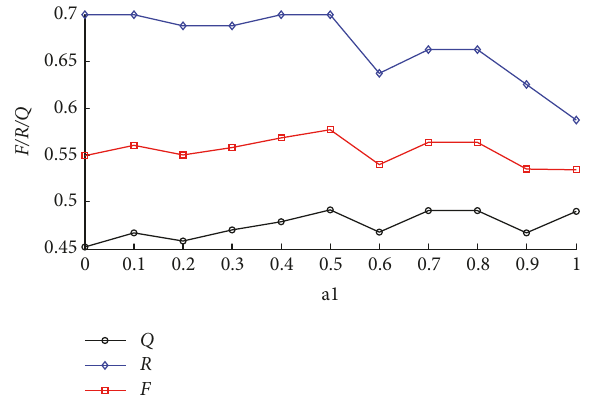
Figure 2: The comparison of the obtained results when a 1 is given different values and 𝑉 threshold = 0.1.